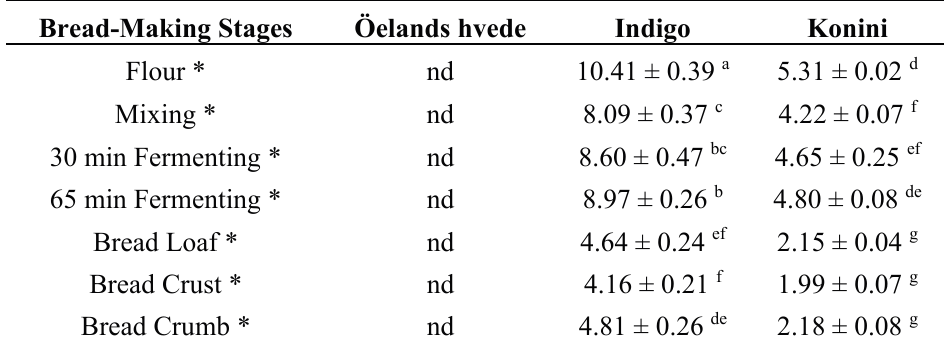
Table 5. Total anthocyanin content using pH differential